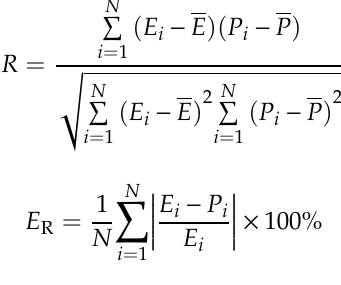
Figure 10. Permanent microscopic strength values of the Mg 17 Al 12 phase at different temperatures. [37].